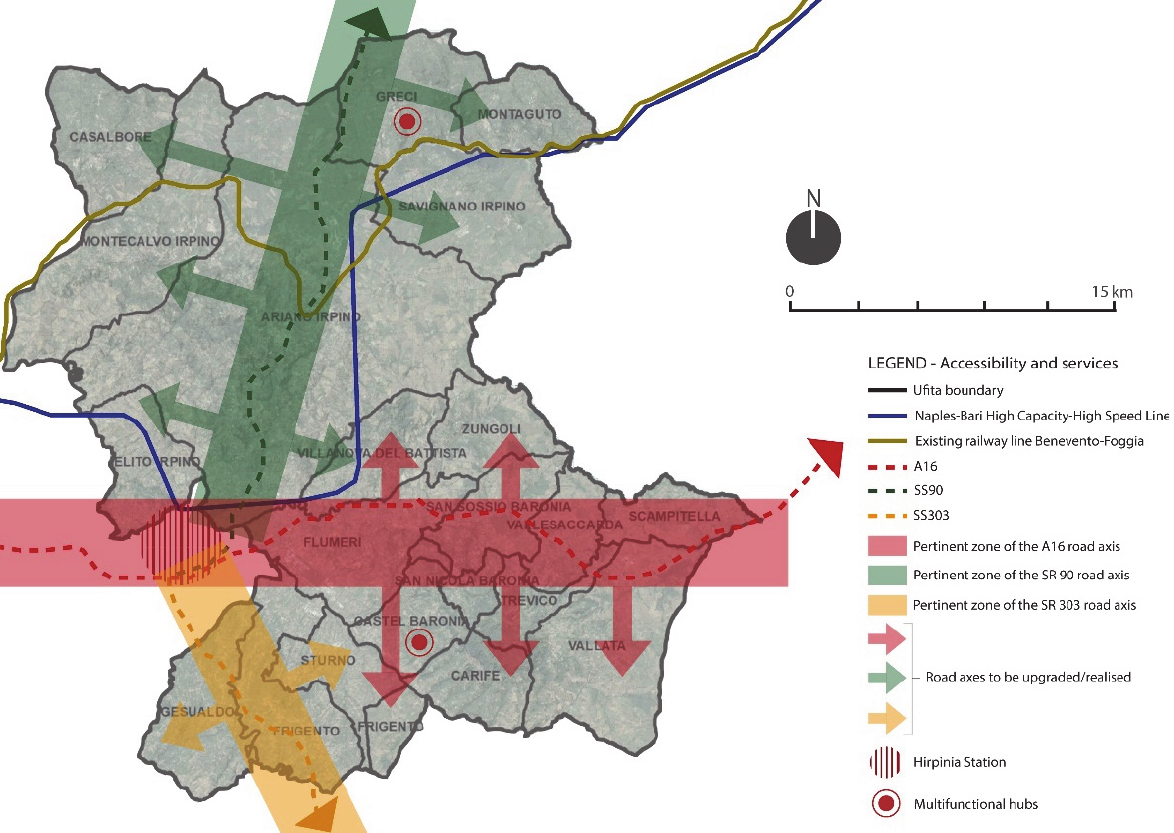
Figure 8. Area strategy for the “Accessibility, services and risk mitigation” axis © RI.P.R.O.VA.RE Project (DICIV research unit).